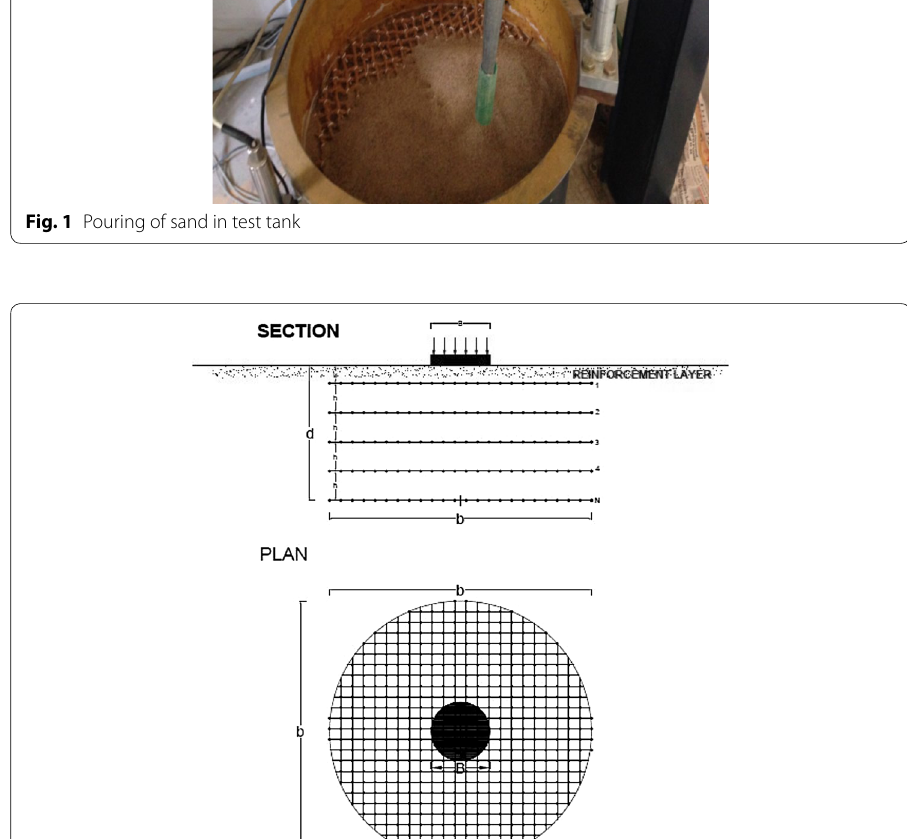
Fig. 2 Plan and section of placement of number layers of coir mat in